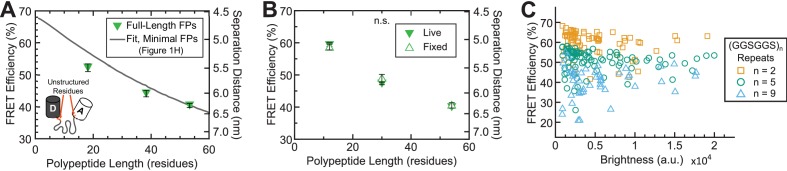
FRET efficiency measurements depend on the presence of unstructured residues in FPs, but are insensitive to fixation and sensor intensity.(A) Quantification of FRET-polypeptide length relationship for (GPGGA)n extensible domains flanked by full-length Clover-mRuby2 FPs (containing unstructured residues, orange) as compared to model fit of the same module containing ‘minimal’ FPs (from Figure 1H); each point represents at least n = 47 cells pooled from three independent experiments; difference in slope of FRET-length relationship indicates that the unstructured residues in full-length FPs change the effective mechanics of the extensible domain, especially at short polypeptide lengths, an undesirable property in tension sensor modules. (B) Quantification of FRET-polypeptide length relationship for ‘minimal’ Clover-mRuby2 based TSMods in cellulo either live or fixed; each point represents at least n = 9 cells per experiment from three independent experiments; analysis of covariance (ANCOVA) was used to provide a model-independent assessment of statistical differences; ANCOVA interaction term p>0.05 indicates that the relationship between FRET efficiency and polypeptide length is not significantly different (n.s.) between live and fixed conditions; error bars, s.e.m. (C) FRET efficiency measurements as a function of mean acceptor intensity (brightness) for fixed cells expressing TSMods consisting of the ‘minimal’ Clover-mRuby2 FRET pair and (GGSGGS)2,5,9 extensible domains (R2 = 0.06, 0.01, 0.03 and n = 74, 86, 48 cells, respectively; data pooled from three independent experiments).10.7554/eLife.33927.005Figure 1—figure supplement 1—source data 1.FRET-length relationships for TSMods in various conditions.